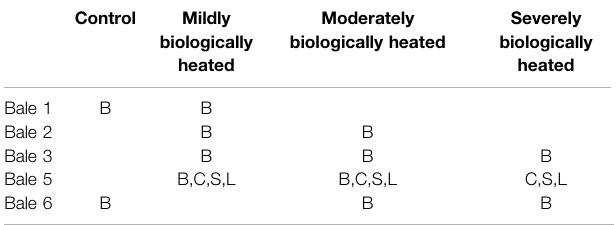
TABLE 1 | Corn stover samples used in this study, “ B ” indicates bulk (unfractionated), “ C, ” “ S, ” and “ L ” indicate the fractions, cob, stalk and leaf, respectively.